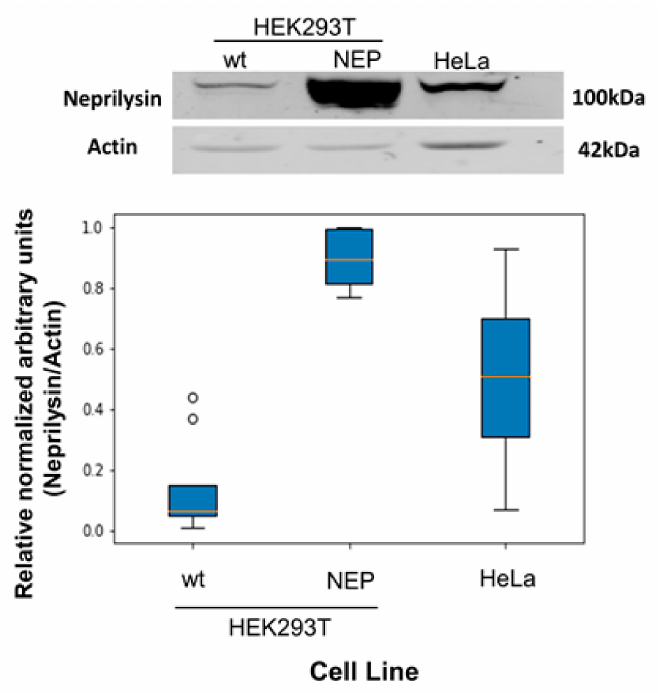
Figure 5. Protein expression levels of neprilysin in HEK293T, HEK293T-NEP and HeLa cell lines. The top panel shows a representative Western blot comparing NEP expression level in HEK293T cells parental (Wt) and HEK293T transfected cells stably over-expressing NEP (HEK293T-NEP) and HeLa cells. The bottom graph shows a densitometric analysis of the corresponding expression ( n = 6 for HEK293T-NEP cells and n = 10 for the other cell lines). All paired comparisons reported p values < 0.05, hence all are considered significantly different. Raw images for the Western blots are presented as Figure